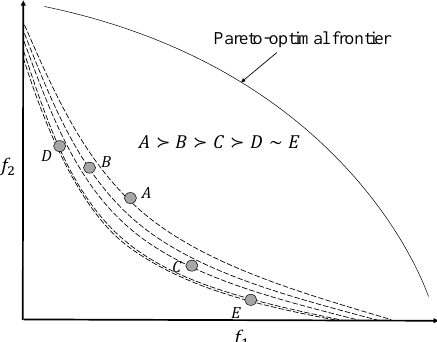
Figure 14. Value function fitting when the points are partially